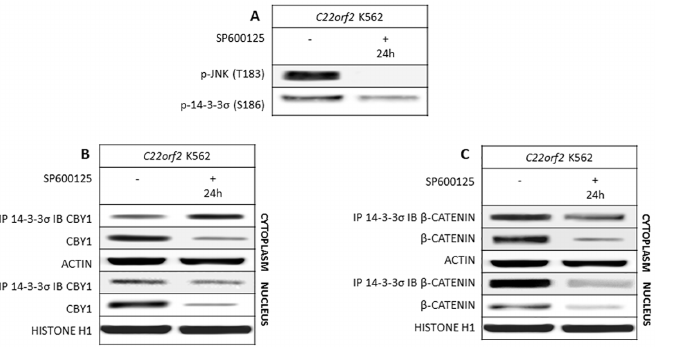
Fig 4. JNK and 14-3-3 σ de-phosphorylation at threonine 183 and serine 186, respectively, in response to JNK inhibitor SP600125 prevents the dissolution of CBY1/14-3-3 σ complex and leaves steady the cytoplasmic expression of CBY1. A- SP600125 inhibitory effects on its targets (JNK and 14-3-3); B- CBY1 expression and interaction with 14-3-3 σ and β catenin expression and interaction with 14-3-3 σ were assayed in the cytoplasmic and nuclear compartments of C22orf2 K562 cells 24 th hour of exposure to SP600125. The absence of off-target effects was assayed (Supplementary section, S2 Fig). See legend to Fig 1 for technical